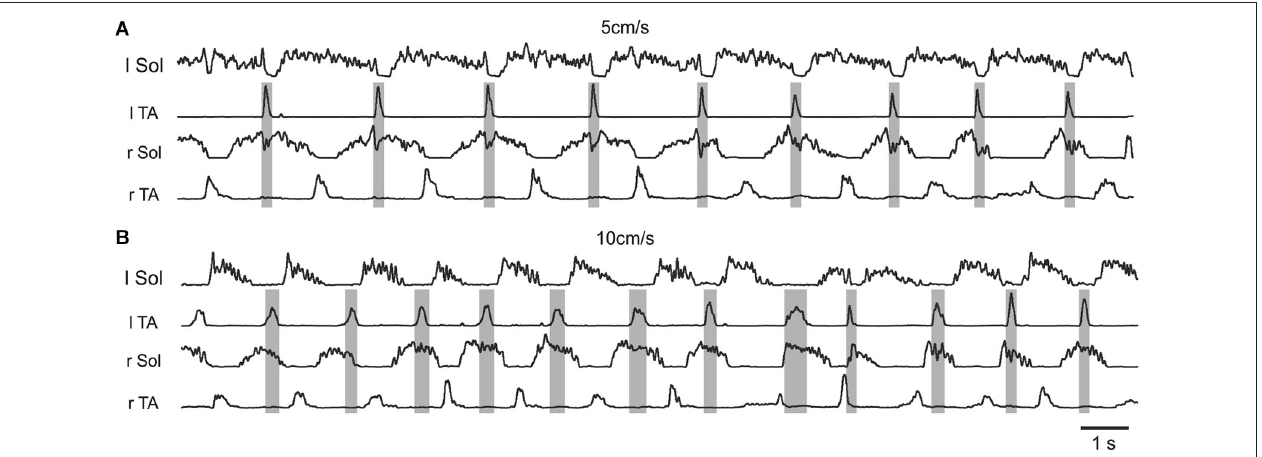
FIGURE 4 | Examples of rectified and filtered EMG records from left and right Sol and TA muscles during hindlimb locomotor movements after a low dose (0. 1 mg/kg, i.p.) of quipazine and a subsequent low dose (0.1 mg/kg, i.p.) of 8-OHDPAT in a rat suspended over a moving treadmill